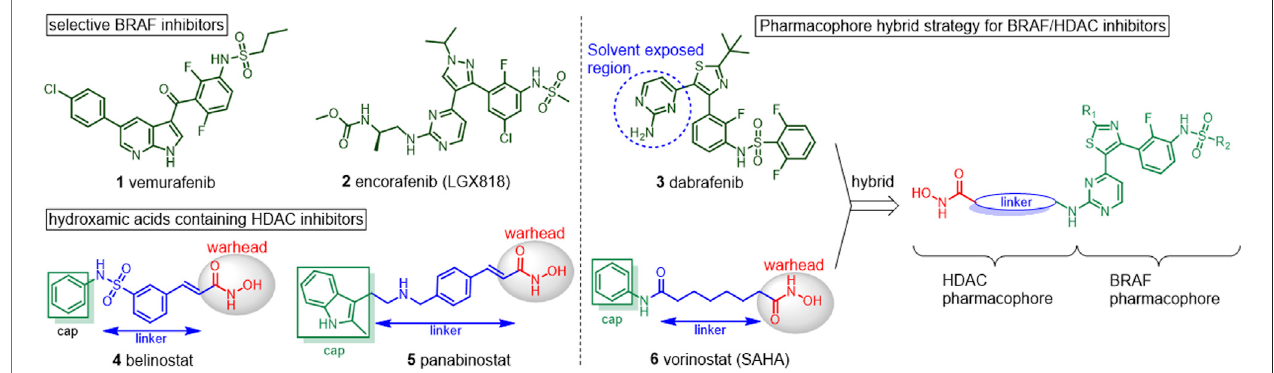
FIGURE 1 | Chemical structures of BRAF inhibitors and HDAC inhibitors and the pharmacophore hybrid strategy for BRAF/HDAC inhibitors.